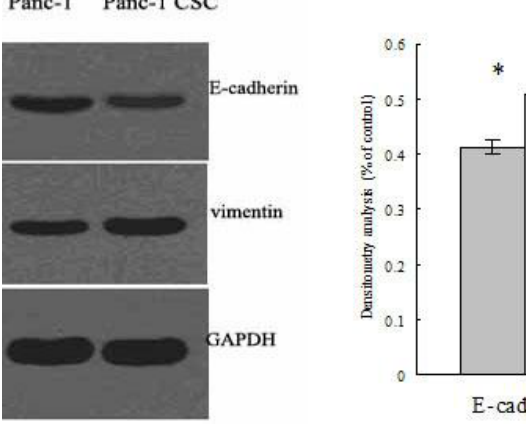
Figure 4. Panc-1 CSCs demonstrate a phenotype suggestive of epithelial to mesenchymal transition (EMT). The expression levels of E-cadherin and vimentin in Panc-1 CSCs and Panc-1 cells were determined by Western blot analysis (left). Densitometry analysis revealed the differences between Panc-1 CSCs and Panc-1 cells (right). * p <